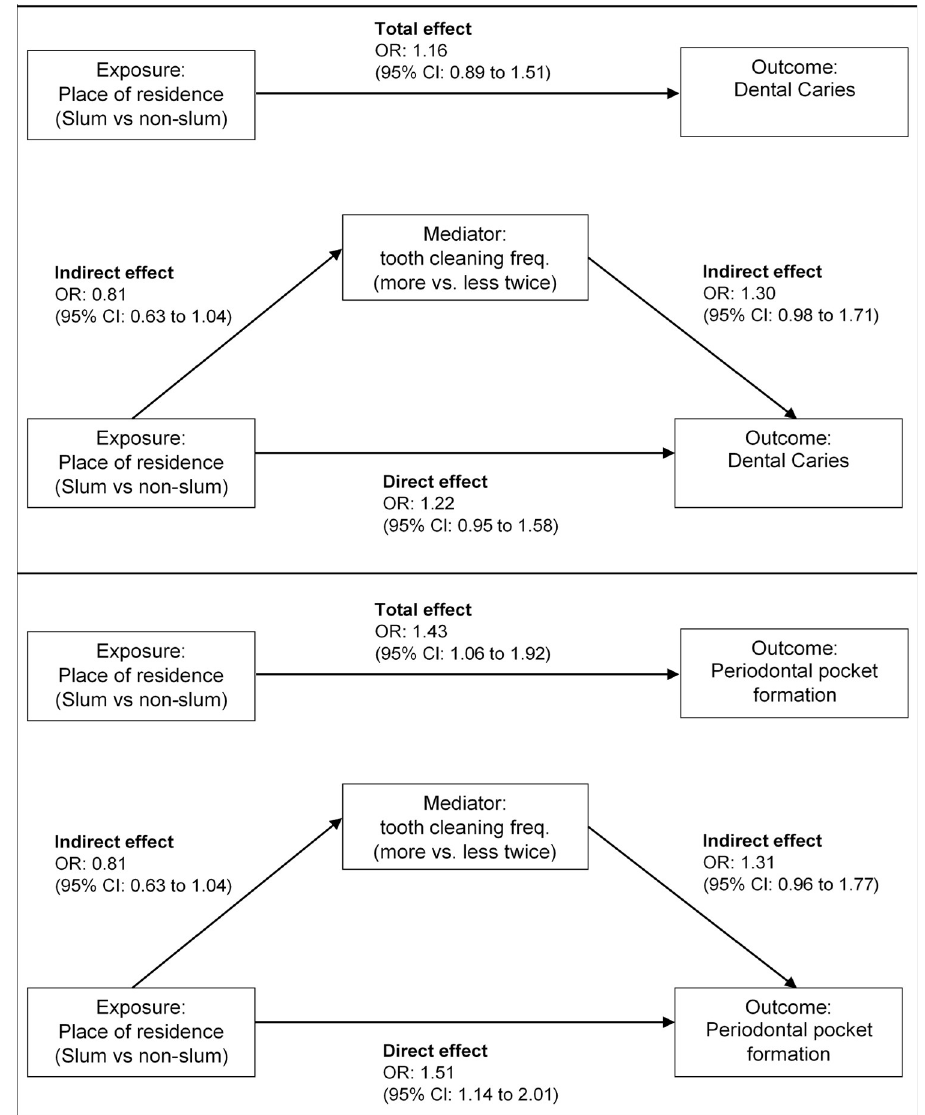
Fig 2. Casual pathways between place of residence and oral health conditions (dental caries and periodontal pocket formation) with frequency of tooth cleaning as a potential mediator, controlling for age group and sex. after adjusting for cariogenic diet, age and sex (direct effects). The odds of having a more fre- quent cariogenic diet were 10% lower (OR = 0.90, 95% CI:0.72 to 1.13) for people in slum com- pared to non-slum residents. The odds of having dental caries was 2% higher (OR = 1.02, 95% CI:0.79 to 1.32) and periodontal pocket formation was 41% lower (OR = 0.59, 95% CI:0.44 to 0.78) for having a more frequent cariogenic diet compared to less, adjusting for place of resi-